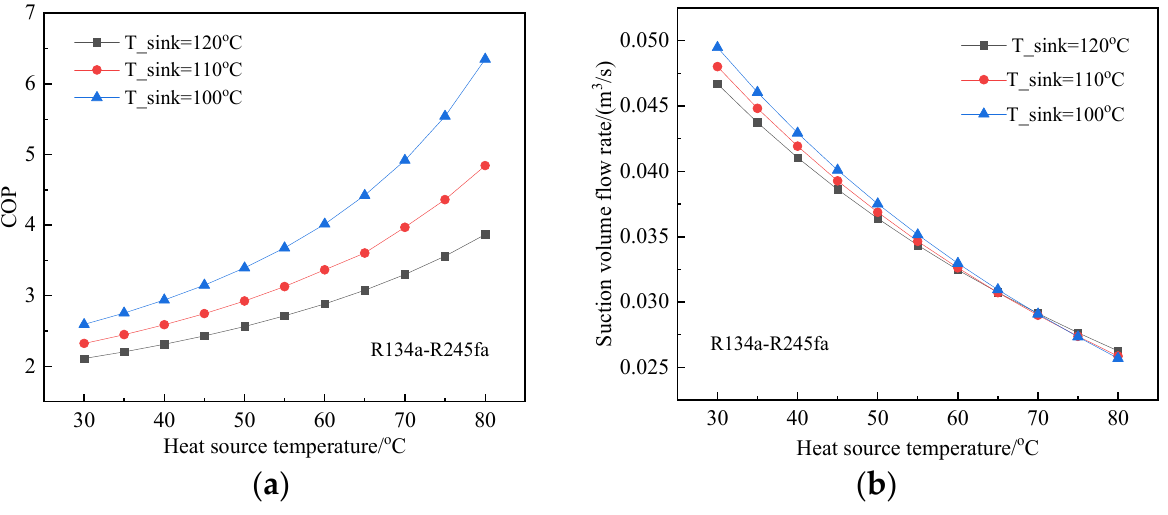
Figure 5. Effects of heat source/heat sink temperatures on the thermodynamic performance. ( a ) COP at various heat source/heat sink temperatures. ( b ) Suction volume flow rate at various heat source/heat sink temperatures.